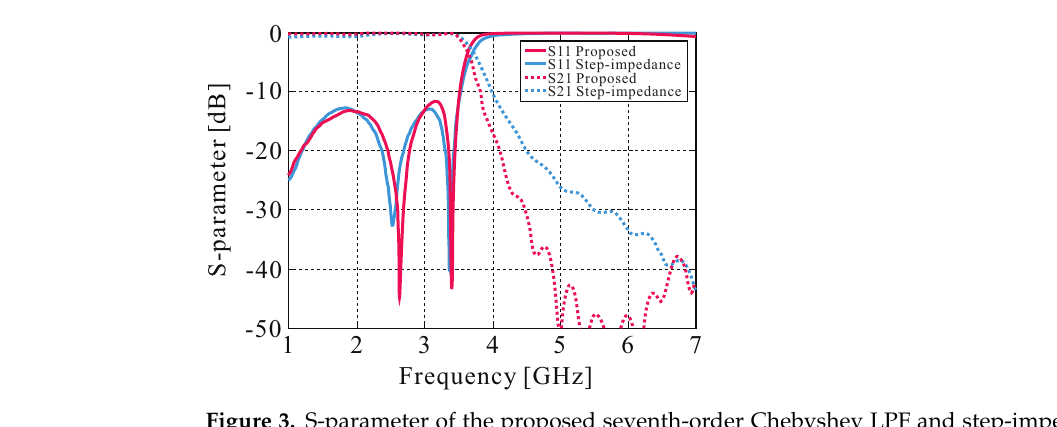
Figure 3. S-parameter of the proposed seventh-order Chebyshev LPF and step-impedance of the same low-pass filter.